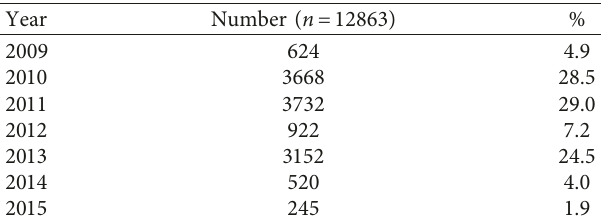
Table 1: Distribution of the studied samples (2009–2015) in Assiut city.